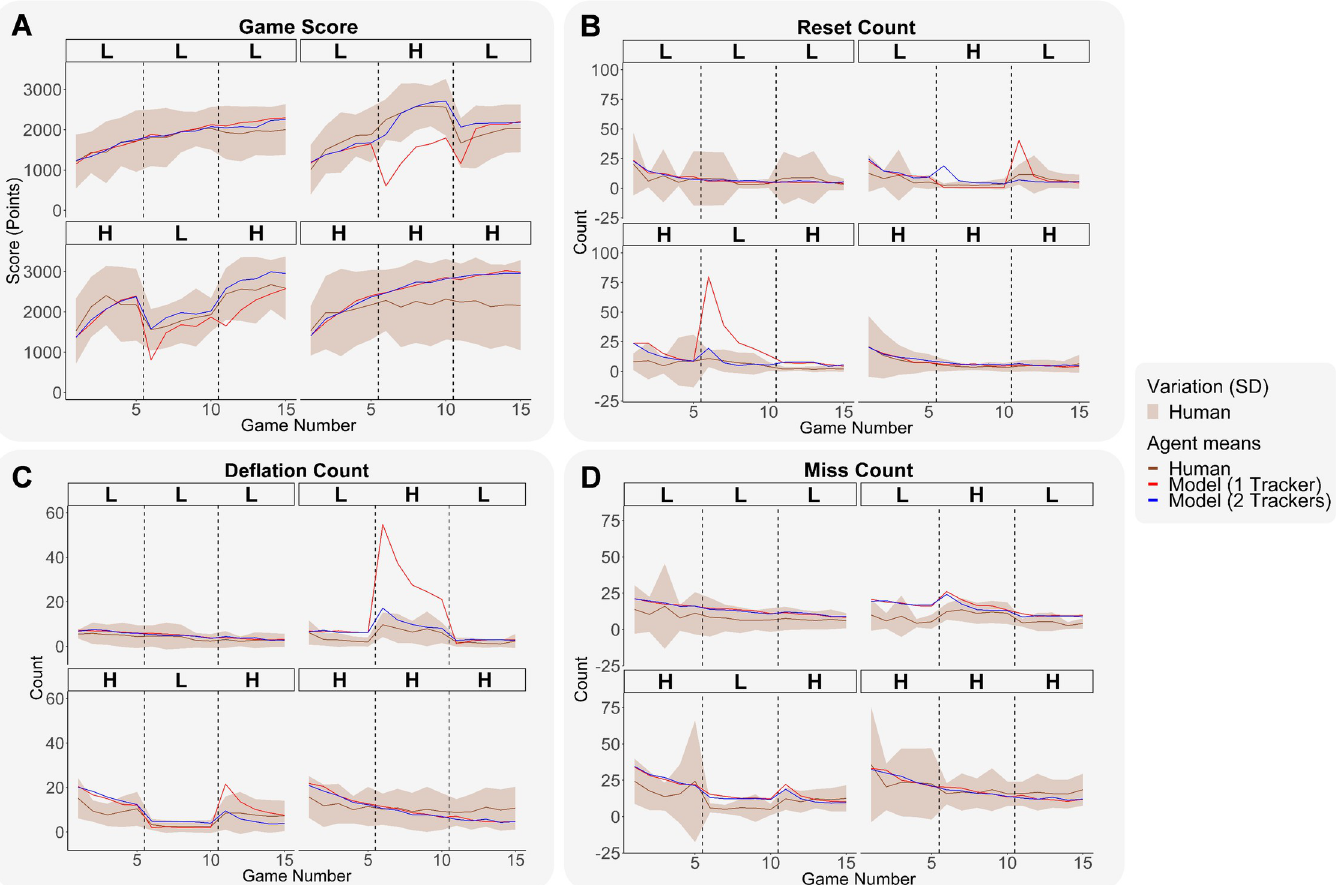
Fig 4. Human and ACT-R model performance results with one vs. two trackers across the four conditions. (A) Game score over the 15 games. (B) Reset count over the 15 games. (C) Deflation count over the 15 games. (D) Miss count over the 15 games. Across all plots, human means are shown with brown continuous lines and human standard deviations are indicated with a light brown shaded area. ACT-R model means with one tracker are shown with red continuous lines. ACT-R model means with two trackers are shown with blue continuous lines. Dashed vertical lines indicate phase switches.